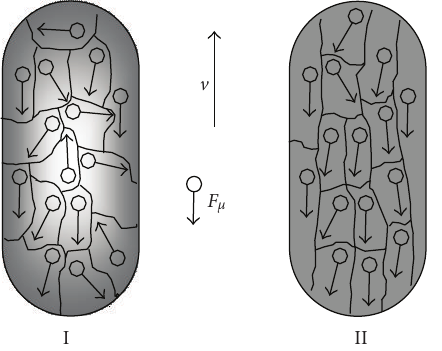
Figure 16: The localization of tire contact forces. I: rolling in driven mode; II: rolling in braking mode; v : velocity; F μ : local maximal friction